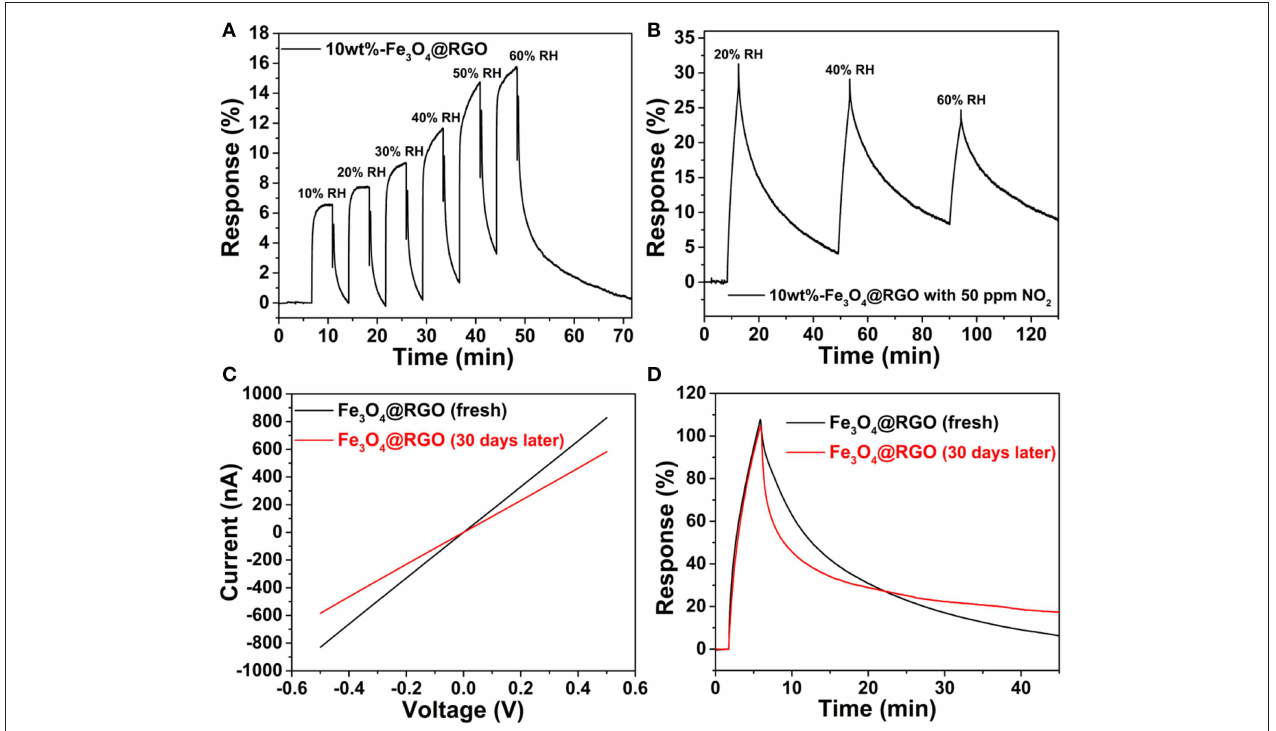
FIGURE 8 | (A) Dynamic curves of 10wt%-Fe 3 O 4 @RGO to different relative humidity. (B) Response curve for 10wt%-Fe 3 O 4 @RGO sensor at different relative humidity for 50 ppm NO 2 . (C) I-V curves and (D) response-recovery curves toward 50 ppm NO 2 of the fresh 10wt%-Fe 3 O 4 @RGO sensor and the sensor after 30 days of